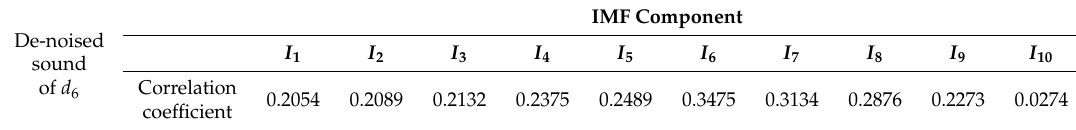
Table 8. Correlation coefficients of each IMF component for an example of de-noised signal of d 6